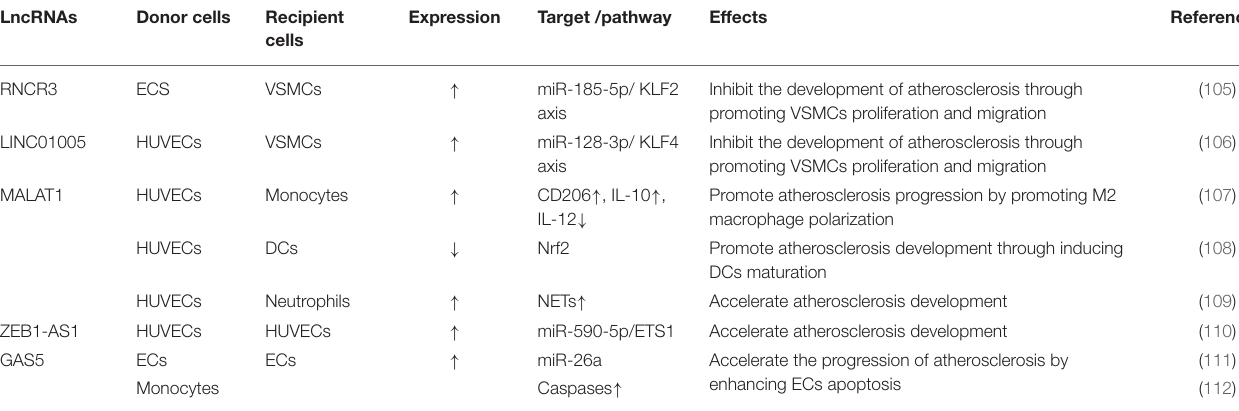
TABLE 2 | Function of lncRNAs in EVs in atherosclerosis.